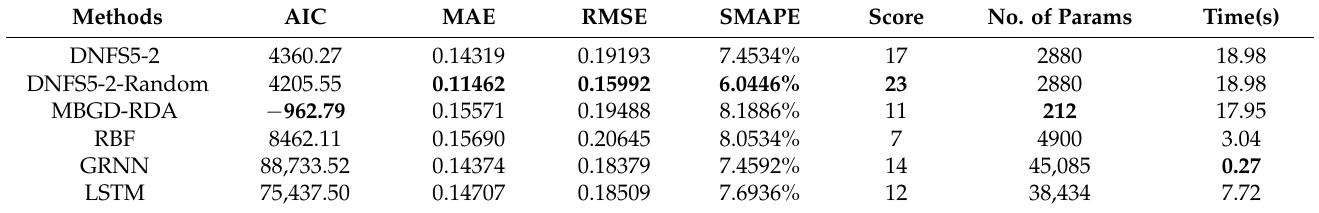
Table 11. The performance of different algorithms on Test Dataset No. 4.